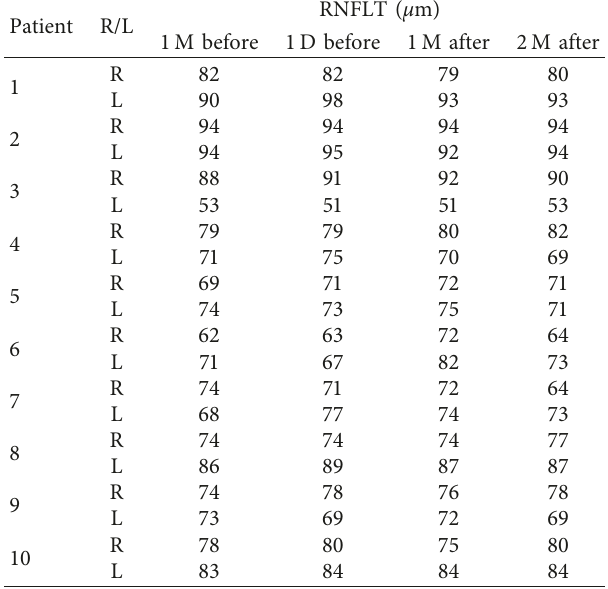
Table 4: Individual data of retinal nerve fiber layer thickness at each measure point.